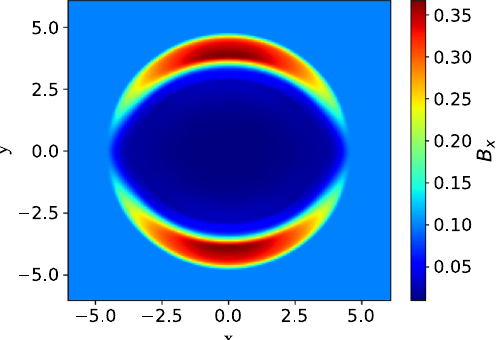
Fig. 7 The magnetic field component B x at t = 4 is shown in the 2D cylindrical explosion problem